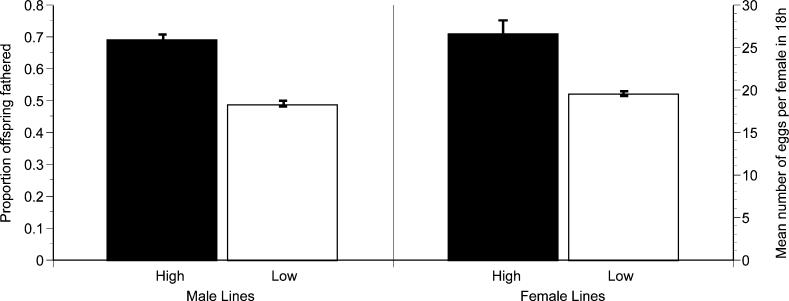
Differences in Fitness between the Lines Selected as Parents for Experimental Crosses Were Substantial and Genetically MediatedIn the male fitness survey (n = 70), the mean proportion of offspring fathered (± 95% confidence interval [CI]) was 0.544 ± 0.016. In the female fitness survey (n = 12), the mean fecundity was 22.85 ± 1.87. Error bars indicate standard errors.